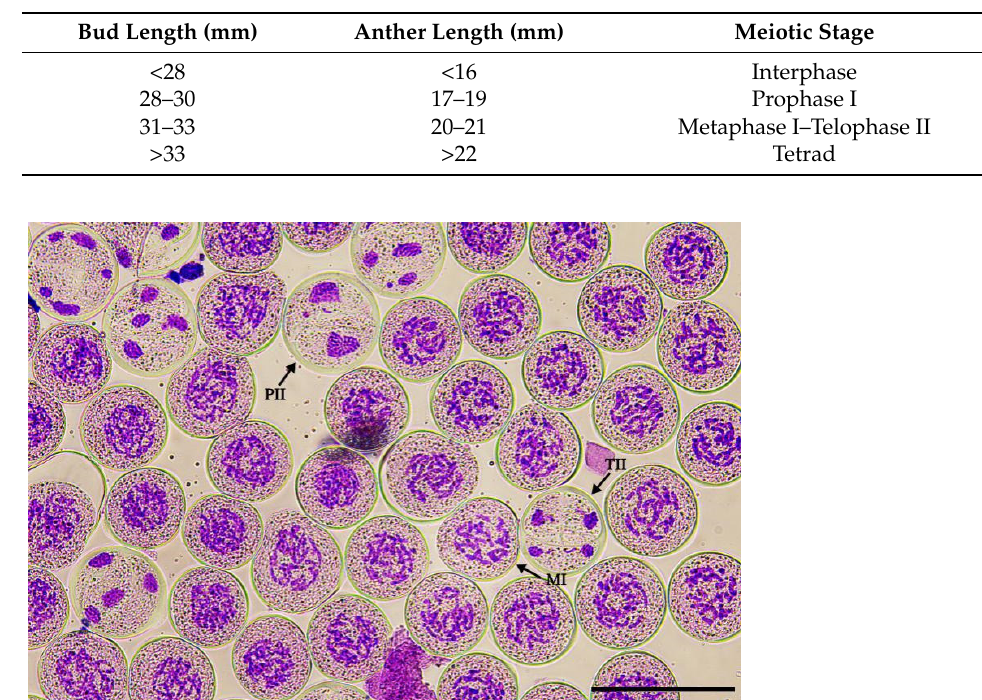
Figure 1. Meiotic processes of PMCs of ‘Black Beauty’. ( a ) Interphase. ( b ) Prophase I. ( c ) Metaphase I. ( d ) Anaphase I. ( e ) Telophase I. ( f ) Prophase II. ( g ) Metaphase II. ( h ) Anaphase II. ( i ) Telophase II. ( j ) Tetrad. Table 1. Correlation between bud/anther lengths and meiotic stage in PMCs of ‘Black Beauty’.